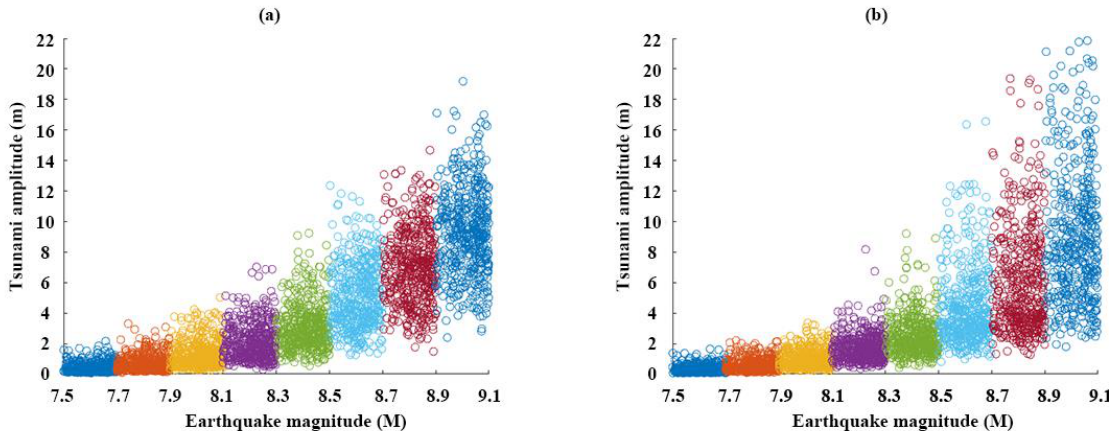
Figure 3. Earthquake rupture and tsunami wave plots for three individual cases of ( a ) M7.6, ( b ) M8.2, and ( c ) M9.1. The yellow triangle represents the midpoint of the earthquake rupture. There are three off-shore sensors, which are A, B and C representing near, middle, and far locations from the coastline. A greater earthquake magnitude tends to generate a larger earthquake rupture in size and higher tsunami waves.